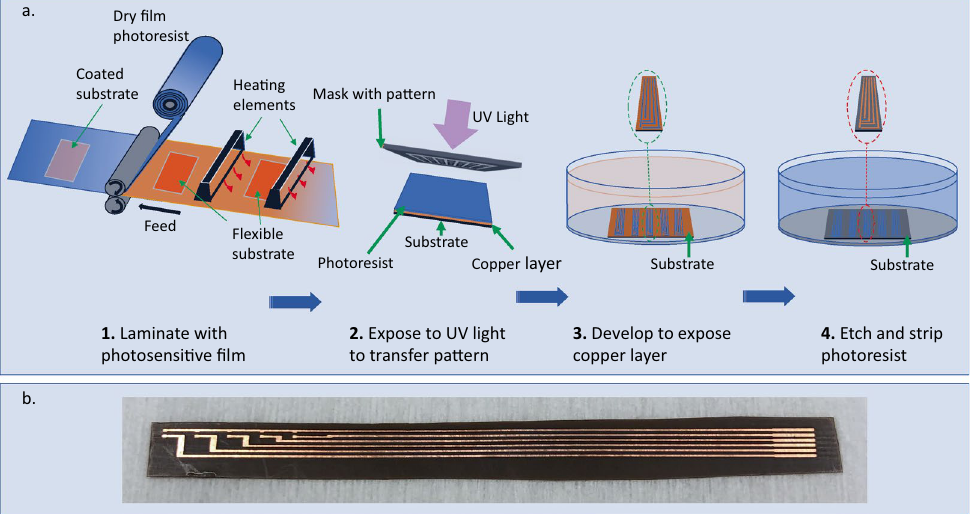
Figure 2. Fabrication process of the flexible Kapton sensors: ( a ) manufacturing steps, ( b ) manufactured sensor